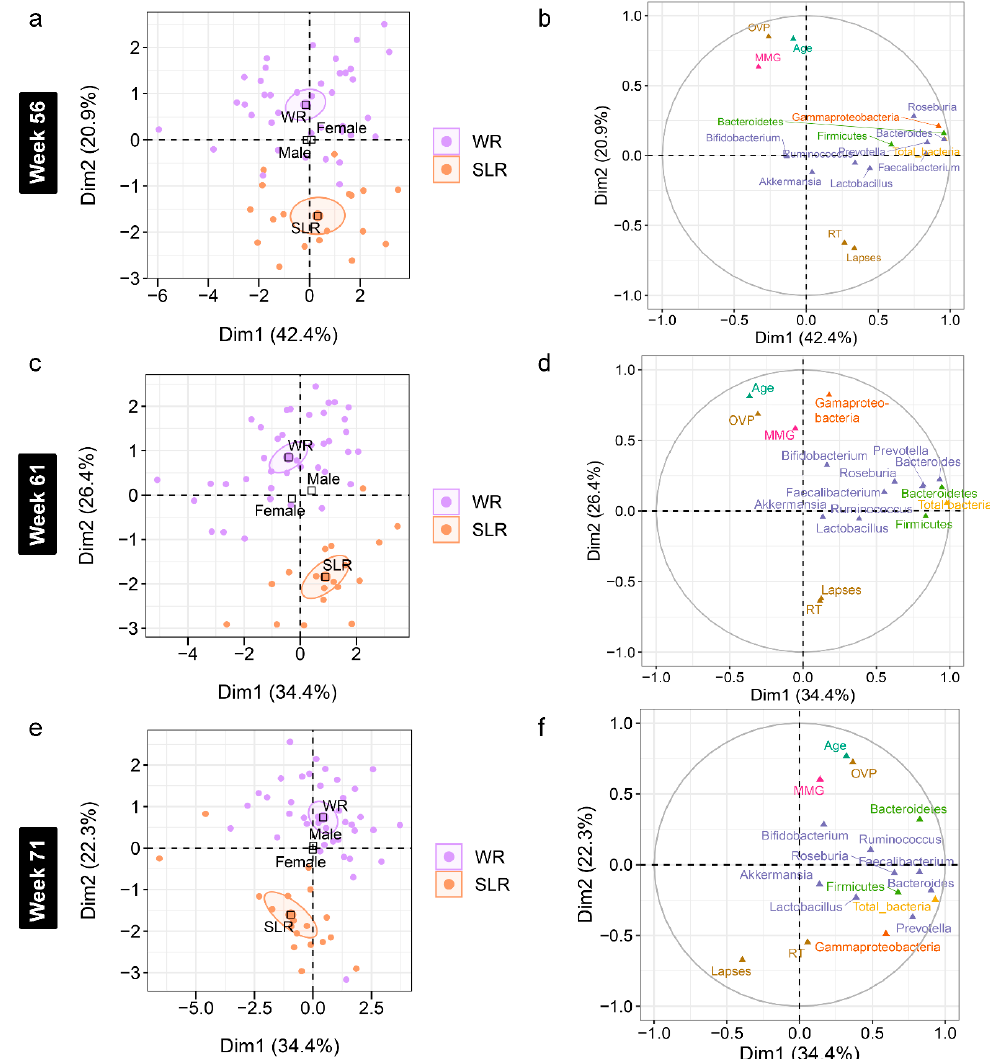
Figure 7. Multiple factor analysis (MFA) of variations in the gut microbiota and cognitive performance of school-aged children explained by the intervention, gender, and age in Phase II. ( a , c , e ) Individual factor maps broken down by the treatment groups (specified by the 95% confidence ellipses) in Dim 1 and 2. ( b , d , f ) Correlation between quantitative variables (gut microbiota at the phylum (green), class (orange), and genus (purple) levels, cognitive performance, and age) and dimensions (Dim 1 and 2). MMG, memory matching game, which denotes Corsi block spans; OVP, overall performance (%); RT, reaction times (millisecond); lapses (millisecond). WR, white rice (control); SLR, Sinlek rice intervention.